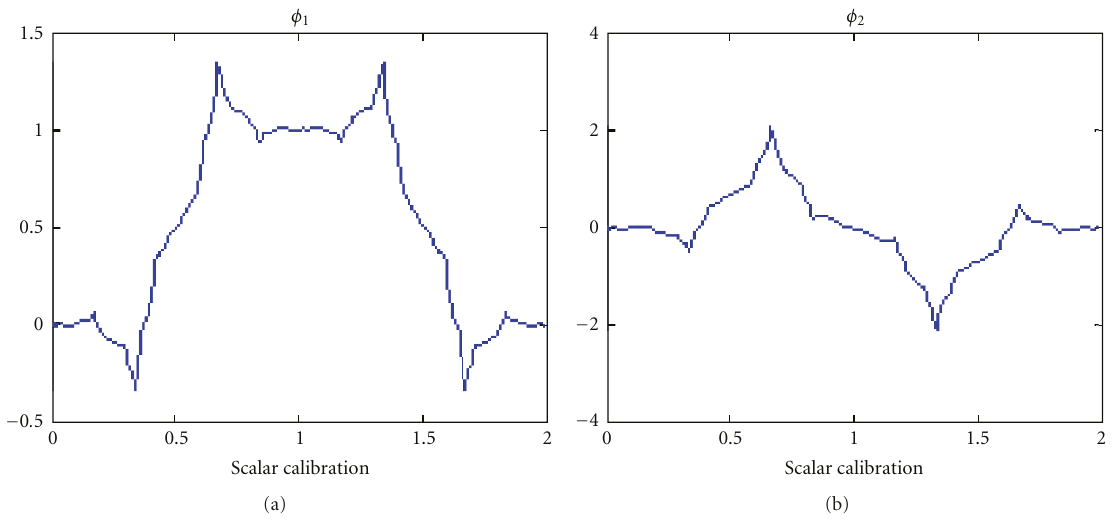
Figure 3: The scaling functions on interval [0, 2] generated by the lengh-3 low-pass filter with θ = π/